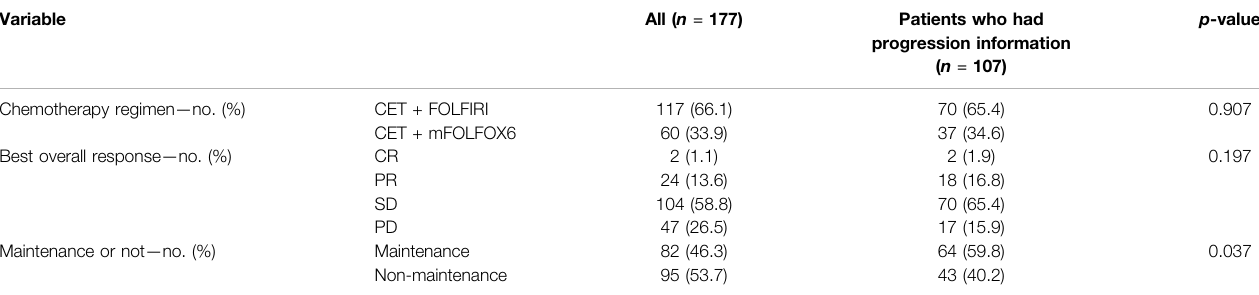
TABLE 2 | Treatment exposure.